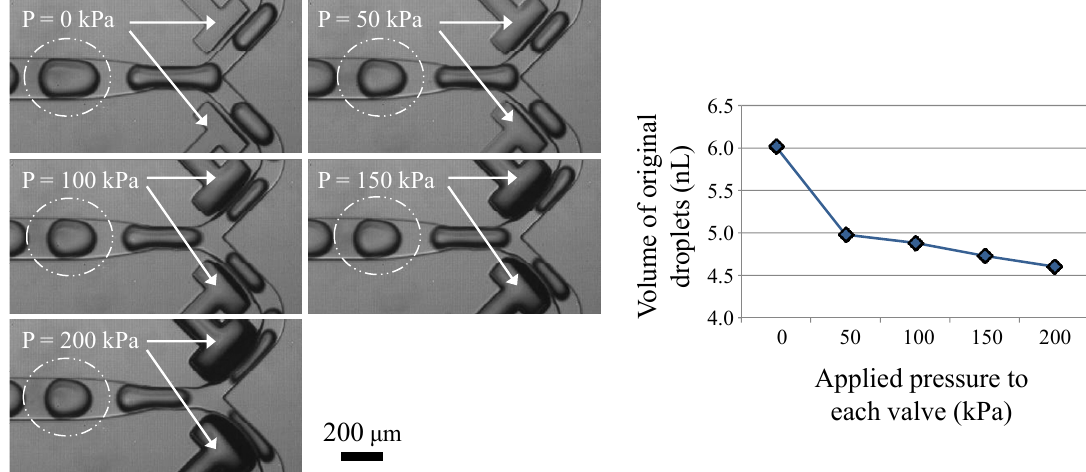
Figure 8. A change in original microdroplets’ volume in upstream due to valve deformation with applied pressure to each